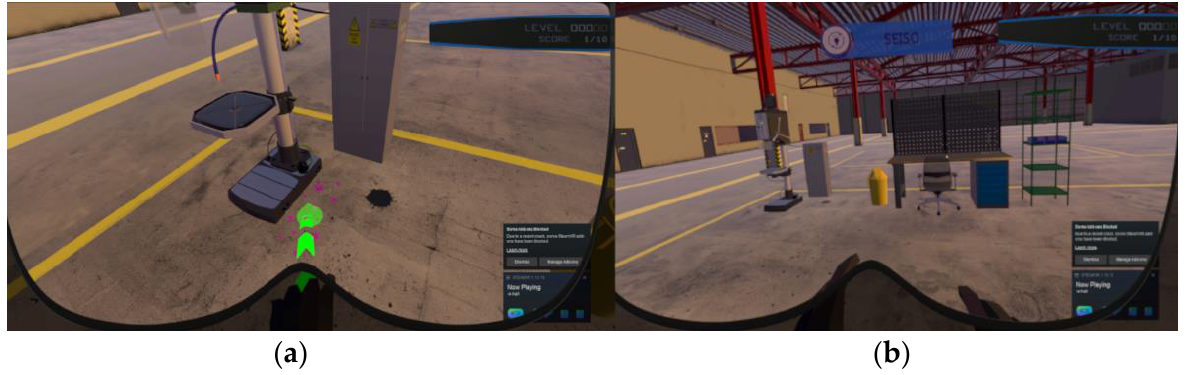
Figure 6. Level 3—( a ) cleaning the floor ( b ) example of the correct arrangement.